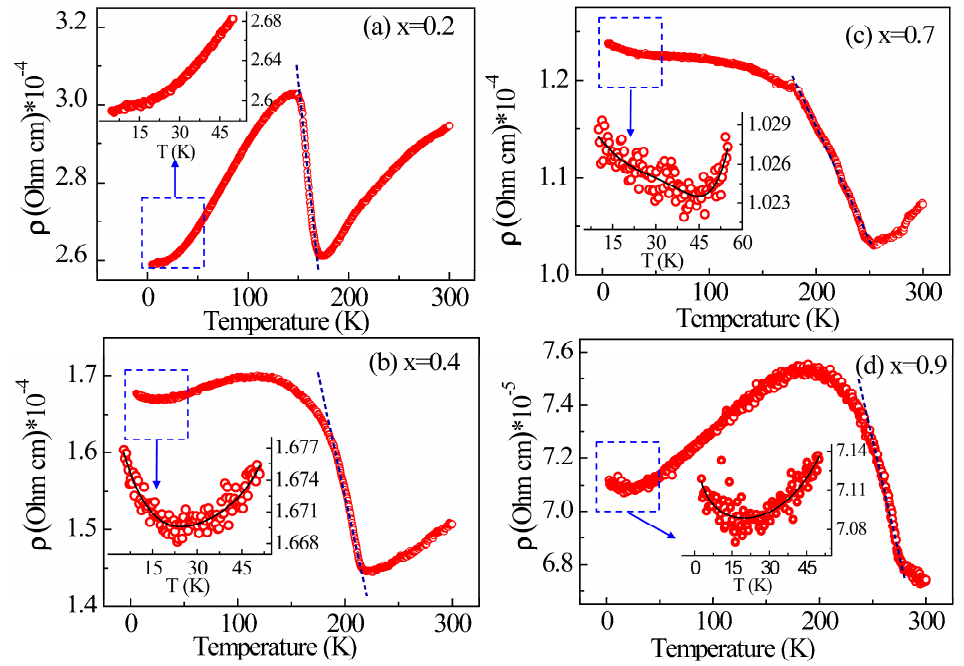
Figure 4. Temperature dependence of ρ for Mn 3 Zn 1 − x Co x N on warming for ( a ) x = 0.2; ( b ) x = 0.4; ( c ) x = 0.7; ( d ) x = 0.9. Insets show low-temperature resistivity data plotted and the fitting (solid line) using function (1) at low temperature. The dashed line represents the jumping zone.